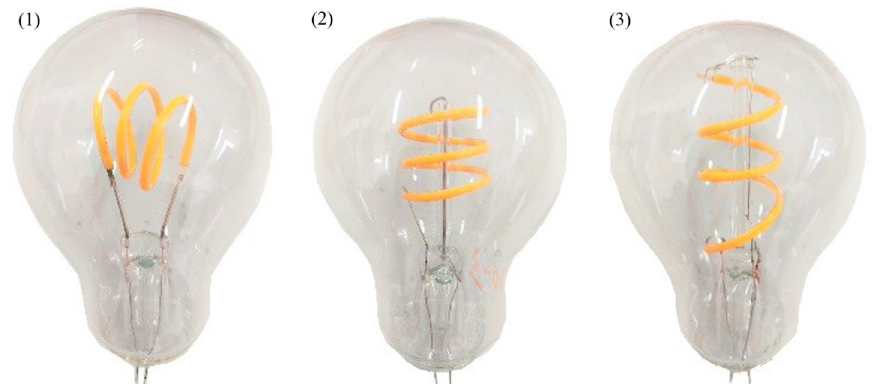
Figure 1. Three different filament arrangements of flexible spiral light emitting diode (LED) bulbs. ( 1 ) Horizontal filament arrangement with a stretch height of 3 cm. ( 2 ) Vertical filament arrangement with a stretch height of 3 cm. ( 3 ) Vertical filament arrangement with a stretch height of 5 cm.